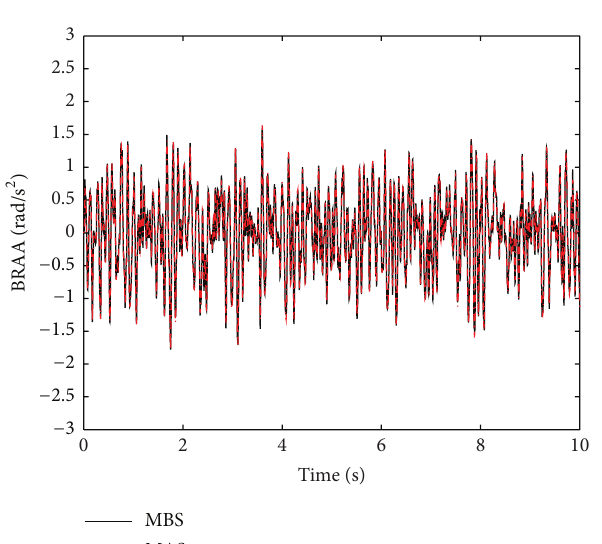
Figure 12: Contrast result of BPAA.